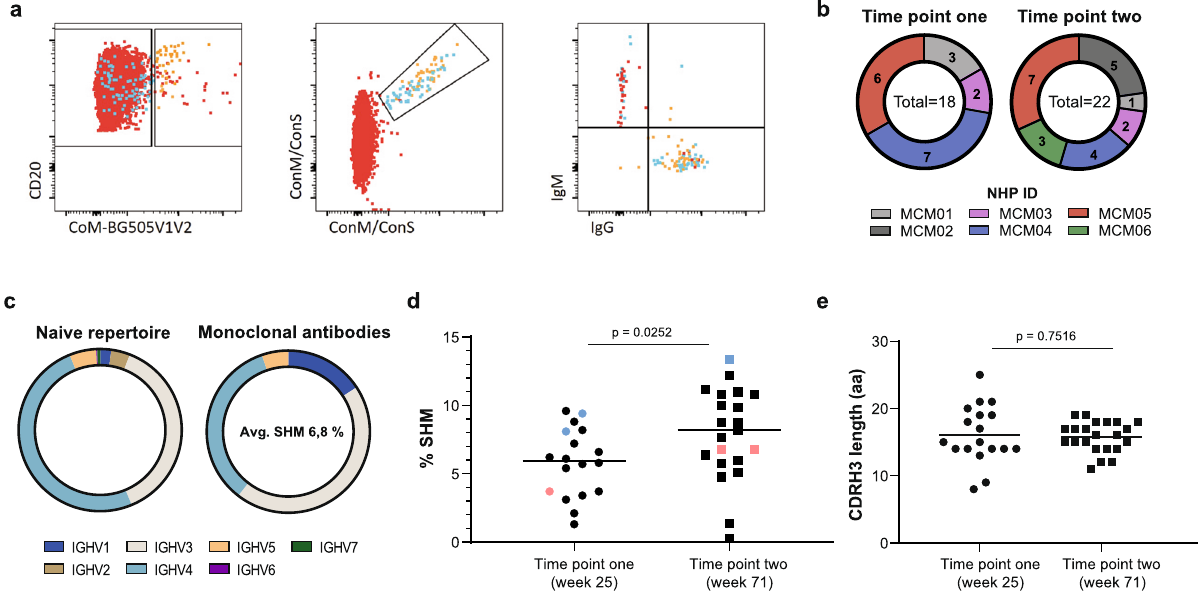
Fig. 2 Characteristics of mAbs isolated from ConM SOSIP.v7 and ConSOSL.UFO.664 immunized NHPs. a For the immunized NHPs, Env- speci fi c B cells were selected by fl uorescence activated cell sorting using three differently labeled SOSIP trimers. ConM-BG505V1V2 protein was used in order to enrich for the V1V2 focused response. The same two fl uorescent labels were conjugated to ConM SOSIP.v7 and ConSOSL.UFO.664 protein to reduce nonspeci fi c background binding, while ConM SOSIP.v7- and/or ConSOSL.UFO.664-reactive cells could be identi fi ed. The gating strategy of one of the NHPs is shown here. b Absolute number of mAbs isolated per animal at time point one (week 25) and time point two (week 71). c The naive HC V-gene repertoire of each individual NHP was mapped through IgDiscover and categorized per IGHV family (IGHV1 – IGHV7) (left). HC V-gene usage for the isolated mAbs was similarly mapped and the average level of SHM for all mAbs combined calculated (right). d The average level of SHM in the HC for mAbs isolated at the fi rst time point (5.8% (range: 1.3 – 9.6%)) increases signi fi cantly at the second time point (8.2% (range: 0.3 – 13.4%)) ( p = 0.0252). Differences were determined by two-tailed unpaired t-test. Two Ab lineages displaying V-gene similarities are depicted in blue (lineage CM05A) and pink (lineage CM04A). e Mean CDRH3 length (in amino acids) for mAbs isolated from all NHPs combined, compared between time point one and two. Differences were determined by two-tailed unpaired t-test ( p =